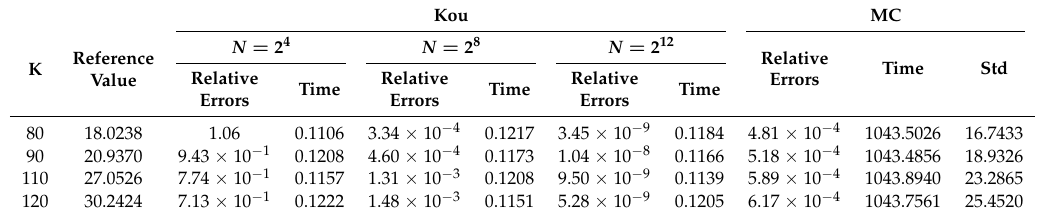
Table 3. Approximation results for GMDB, where X is Kou, b ( s ) = ( K − s ) + .